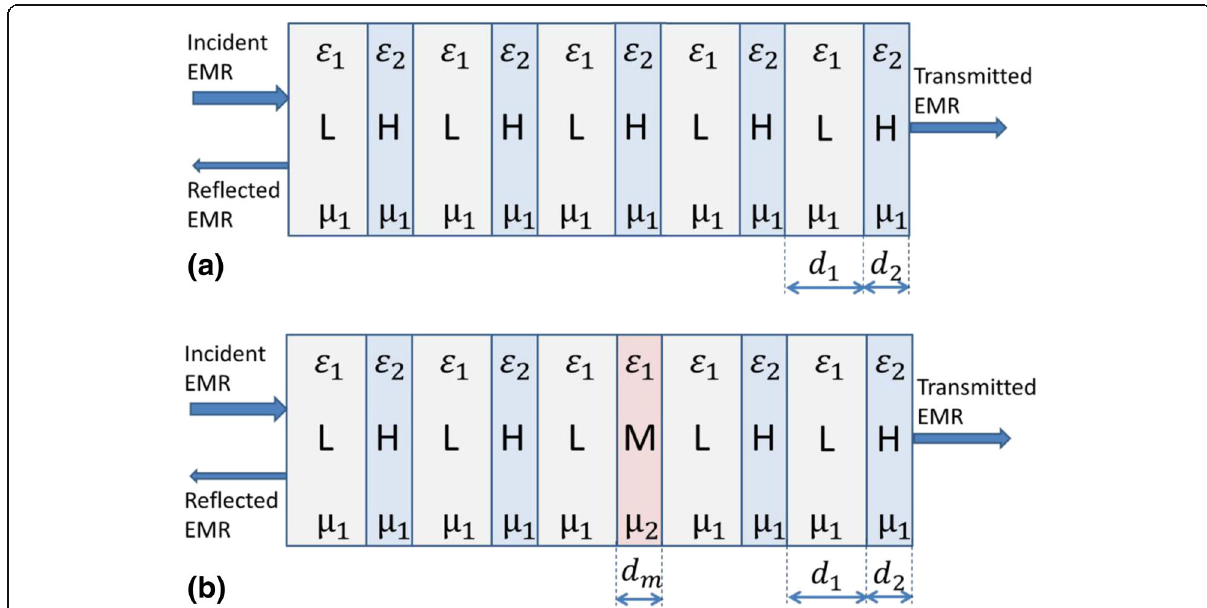
Fig. 1 Model representation of PC transmission by EMR. a Ideal PC structure. b PC structure with one defect magnetic